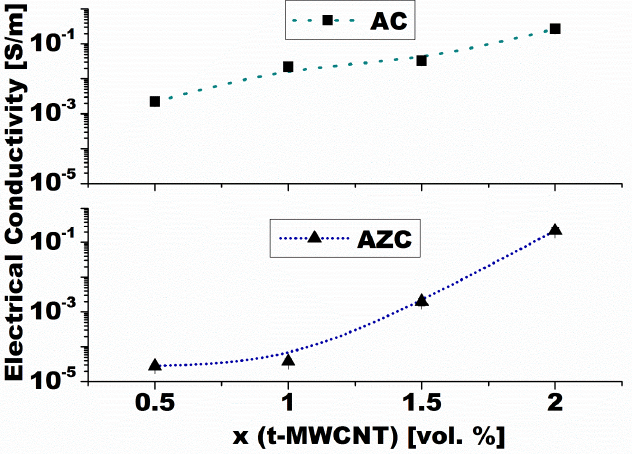
Figure 7. Composition dependence of DC electric conductivity of Al 2 O 3